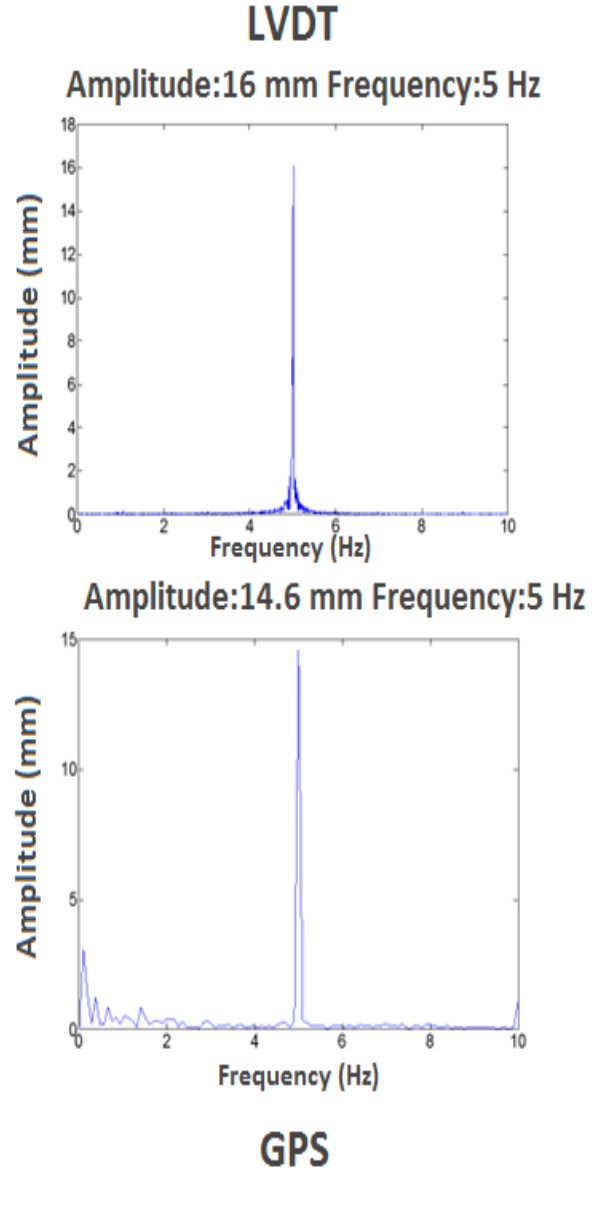
Figure 4. VRS Method Comparison of LVDT and GPS Frequency-Amplitude Values